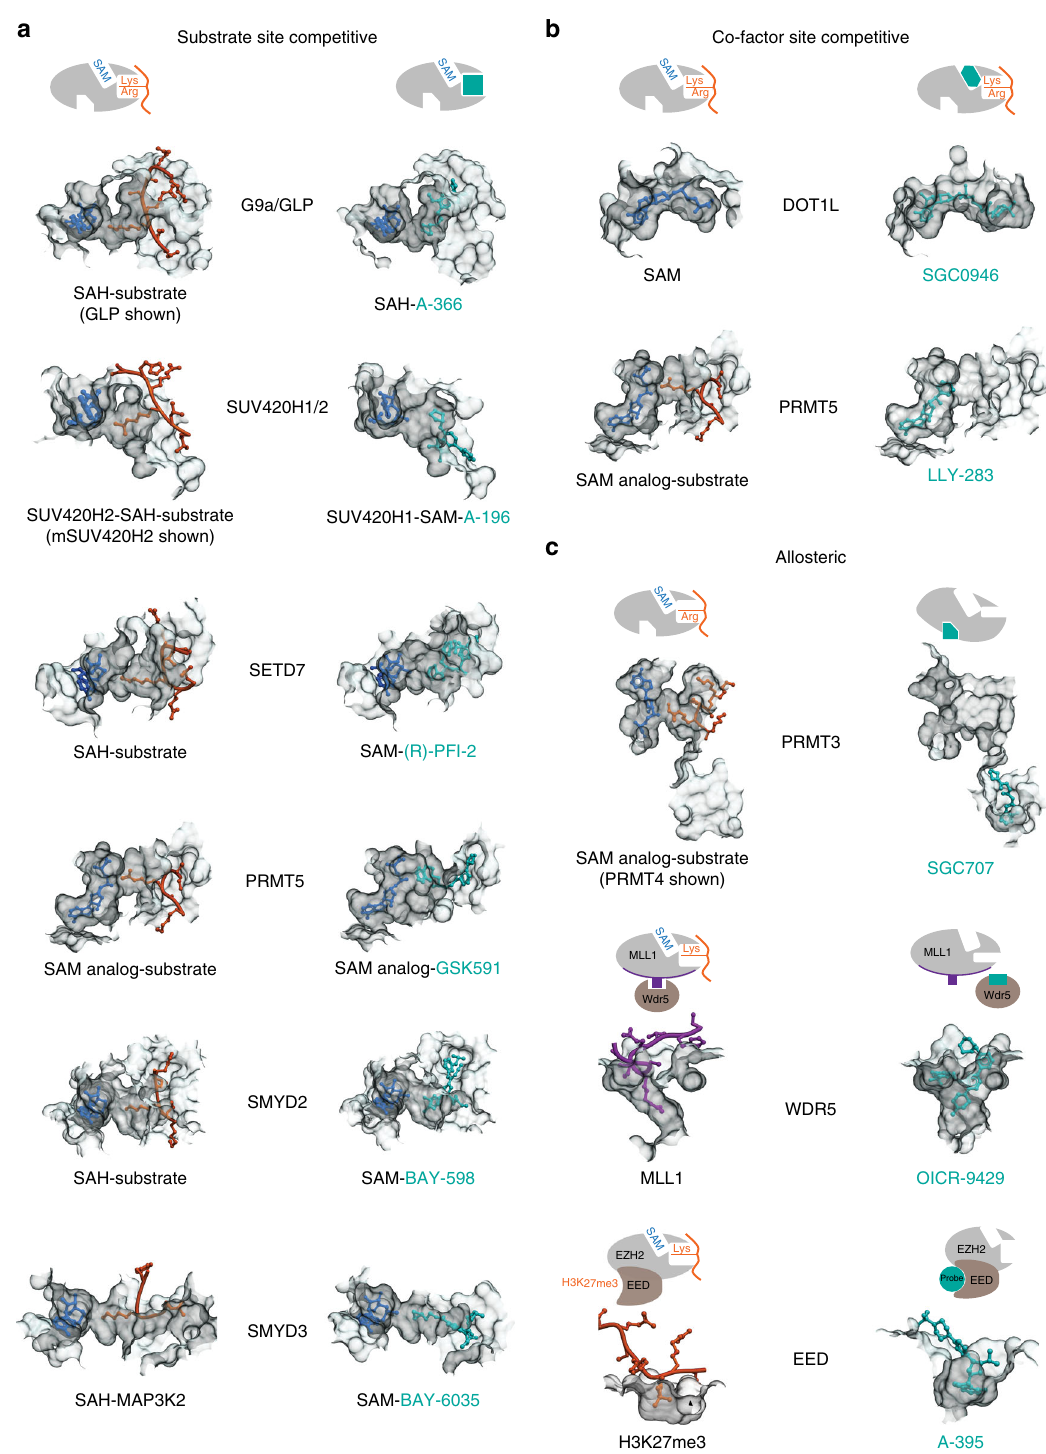
Fig. 2 Structural mechanisms of PMT inhibition by chemical probes. a Inhibitors of G9a (PDB: 3HNA (GLP with H3K9 substrate) and 4NVQ (A-366)); SUV420H2 (PDB: 4AU7 (mSUV420H2 with H4 substrate) and SUV420H1 (PDB: 5CPR (A-196)); SETD7 (PDB: 1O9S (H3 substrate) and 4JLG (PFI-2)); PRMT5 (PDB: 4GQB (H4 substrate) and 5C9Z (GSK591)); SMYD2 (PDB: 3TG5 (p53 substrate) and 5ARG (BAY-598)); SMYD3 (PDB: 5EX0 (MAP3K2 substrate) and (BAY-6035)) all bind in the substrate (peptide) binding pocket. b SGC0946 binds in the SAM-binding pocket of DOT1L thereby preventing cofactor binding (PDB ID: 3QOW (SAM), 4ER6 (SGC0946)). LLY-283 also occupies the SAM-binding pocket of PRMT5-MEP50 complex (PDB ID: 4GQB (SAM analog) and 6CKC (LLY-283)). c Three distinct modes of allosteric inhibition of protein methyltransferases. SGC707 binds to PRMT3 in an allosteric site that prevents productive formation of the enzyme ’ s activation helix (PDB ID: 4RYL). OICR-9429 binds to WDR5 and inhibits MLL1 activity